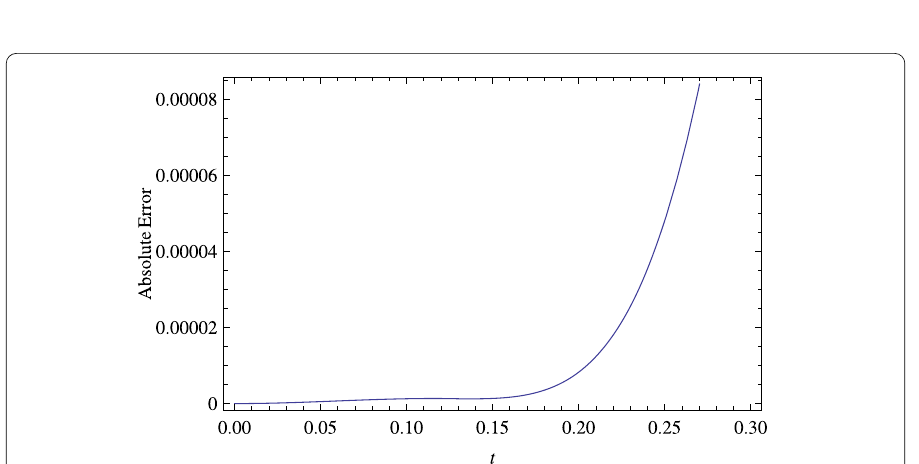
Figure 11 Plot of the absolute error of TFNWS equation when (cid:2) = –0.8 and λ =